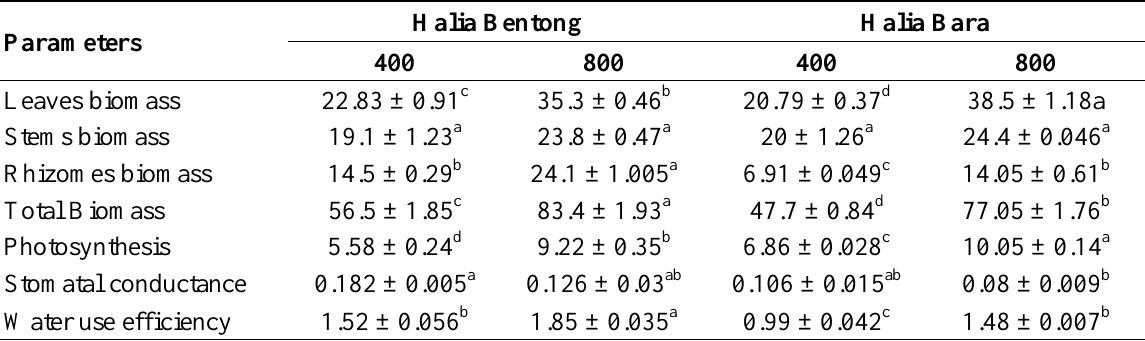
Table 1. Effect of different CO conductance of ginger varieties.